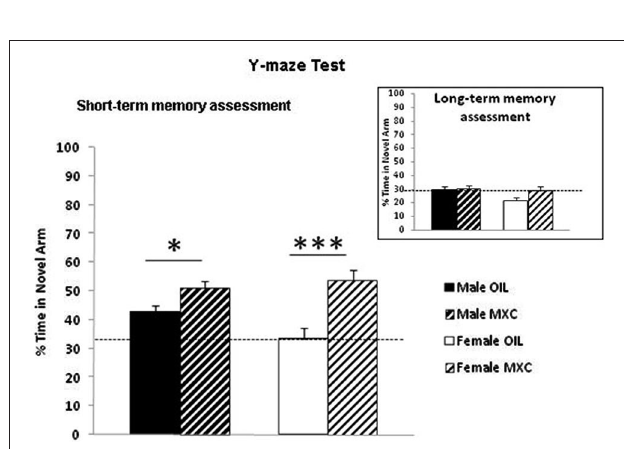
FIGURE 4 | Enhanced short-term working spatial memory through spontaneous alternation in the Y-maze in MXC-treated mice. The percentage of time spent in the novel arm relative to the total duration of visits in the three arms during the test phase revealed an effect of the perinatal MXC treatment. Data are expressed as mean ± SEM. * p < 0.05; *** p < 0.001. In the right corner: assessment of long-term memory after 24 h revealed no significant effects of MXC treatment.